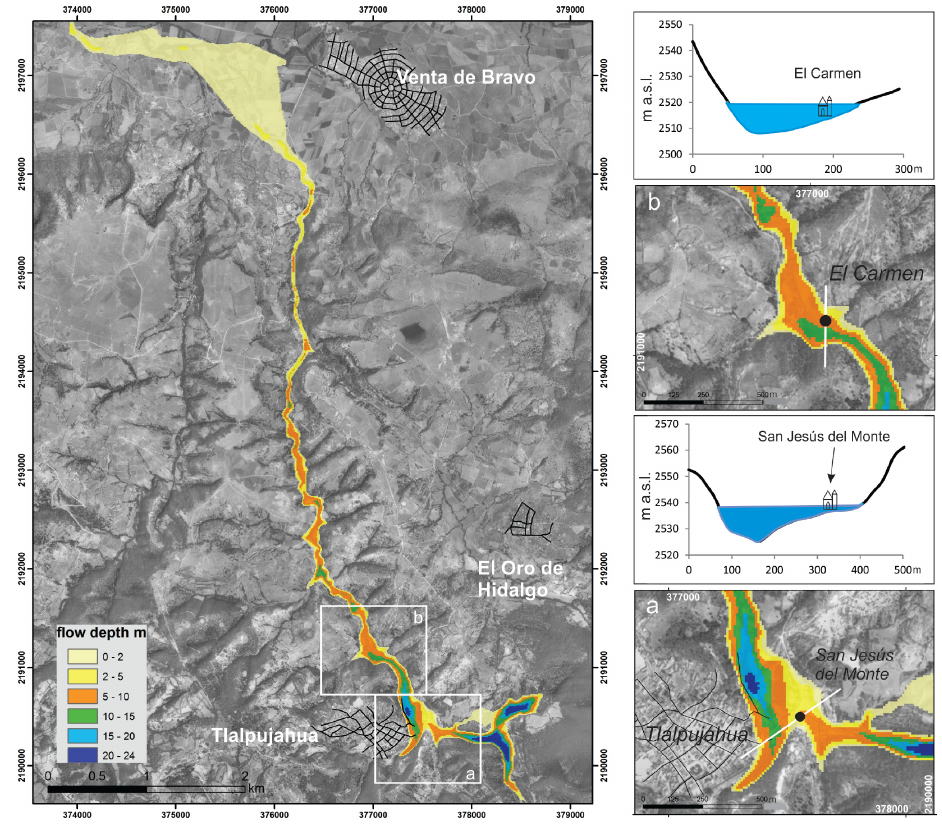
Figure 15. Map showing the maximum depth of the simulated flow and topographic profile at (a) Jesus del Monte and (b) El Carmen churches to illustrate the maximum inundation